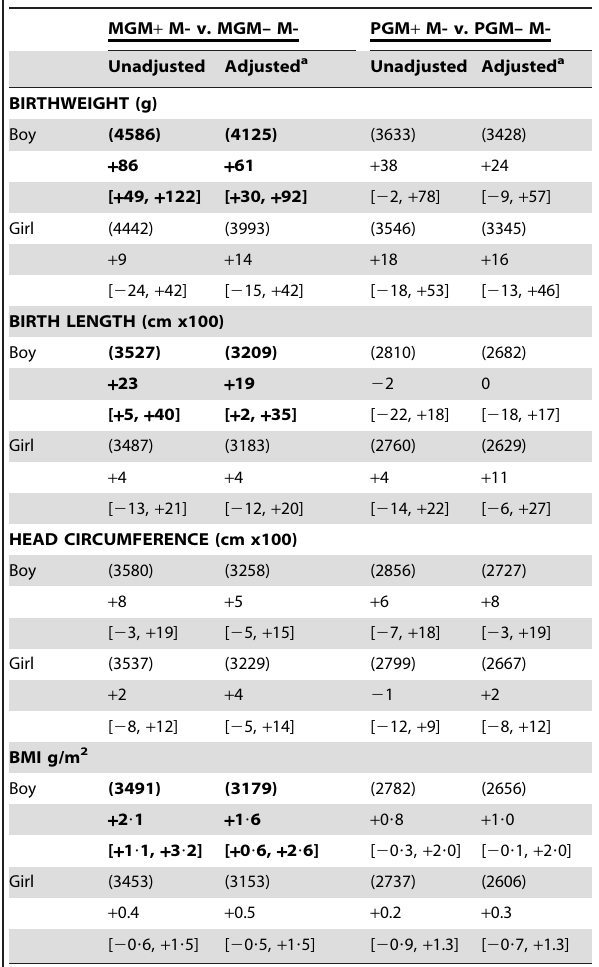
Table 4. Mean difference [95% CI] in birth measurements of children born to non-smoking mothers, comparing those where the child’s grandmother had smoked with those who had